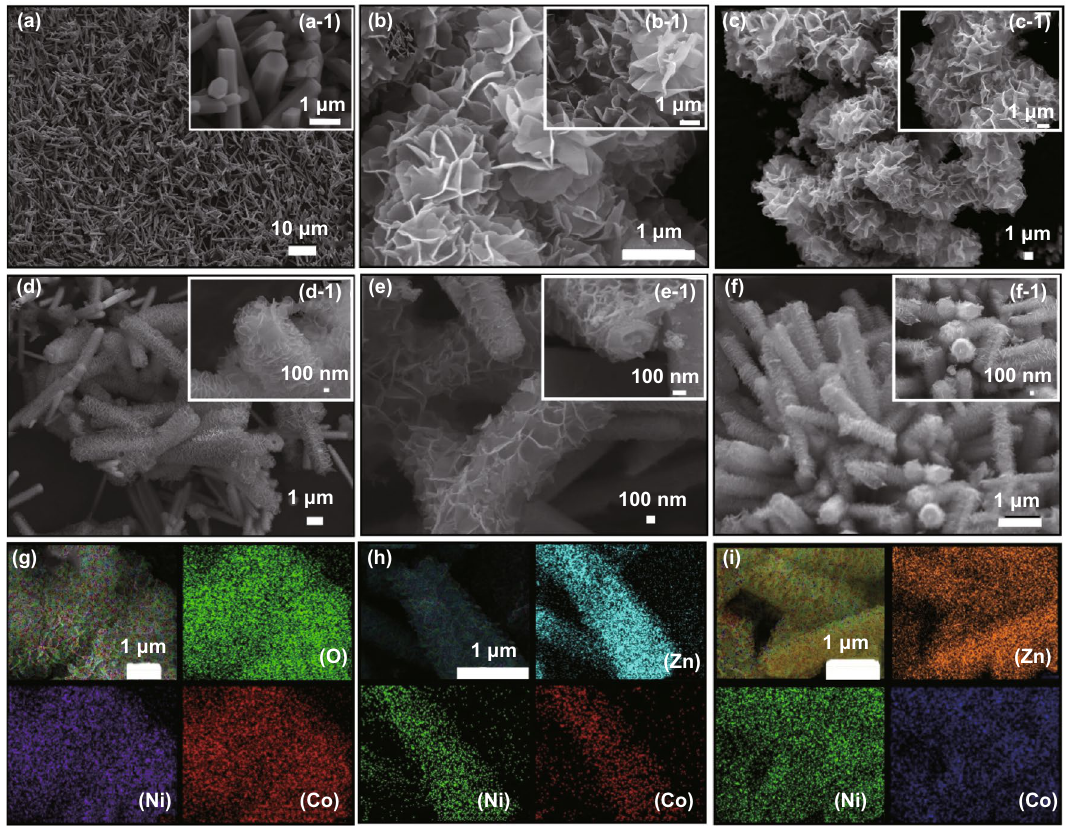
Fig. 2 SEM images of ( a, a-1 ) S-1, ( b, b-1 ) S-2, ( c, c-1 ) S-3, ( d, d-1 ) S-4, ( e, e-1 ) S-5, ( f, f-1 ) S-6 and elemental mapping distribution of g S-2, h S-4, i